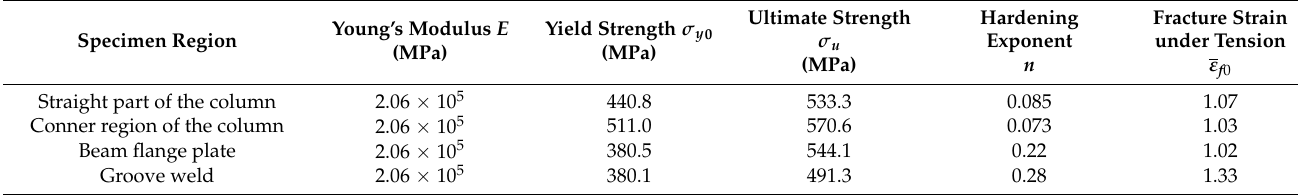
Figure 5. Geometry and configuration of the RP-1 connection specimen (unit: mm) [26,37]. Table 4. Material property at each region RP-1 specimen